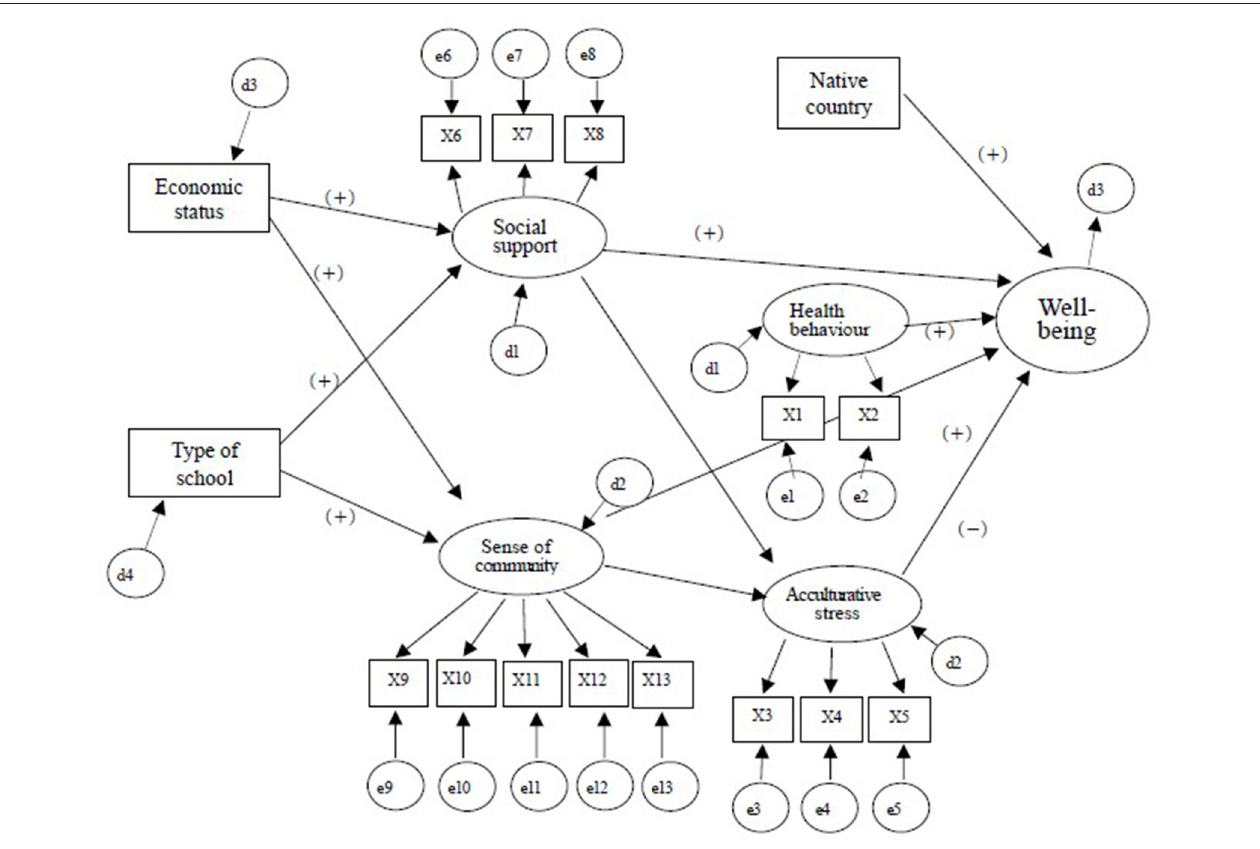
FIGURE 1 | Hypothesized structural equation model. X1: Health behavior and problem, X2: Eating habits, X3: Perceived discrimination, X4: Korean language skill, X5: Feel isolated, X6: Peer support, X7: Family support, X8: Teacher support, X9: Satisfaction of needs and opportunities for involvement, X10: Support and emotional connection with peers, X11: Support and emotional connection in the community. X12: Sense of belonging, X13: Opportunities for